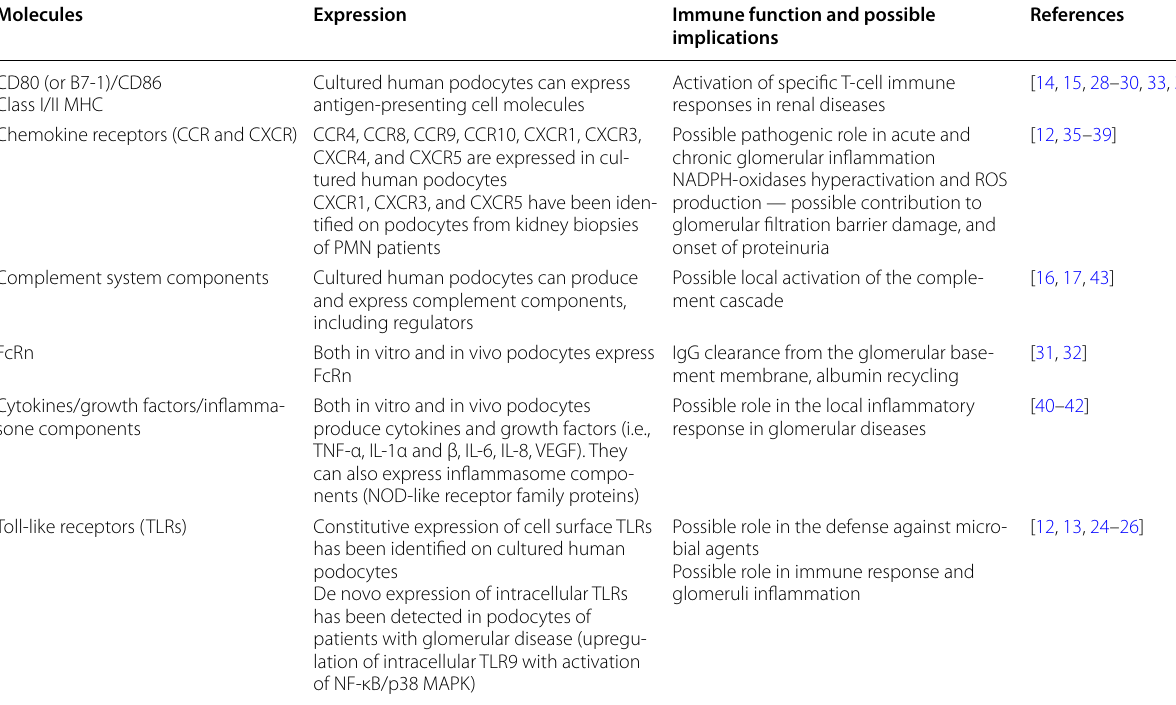
Table 1 Summary of (potential and recognized) podocyte immune